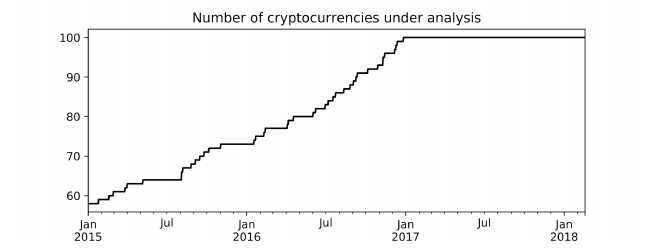
Figure 2: Number of cryptocurrencies under analysis (Jan 2015 - Feb 2018)